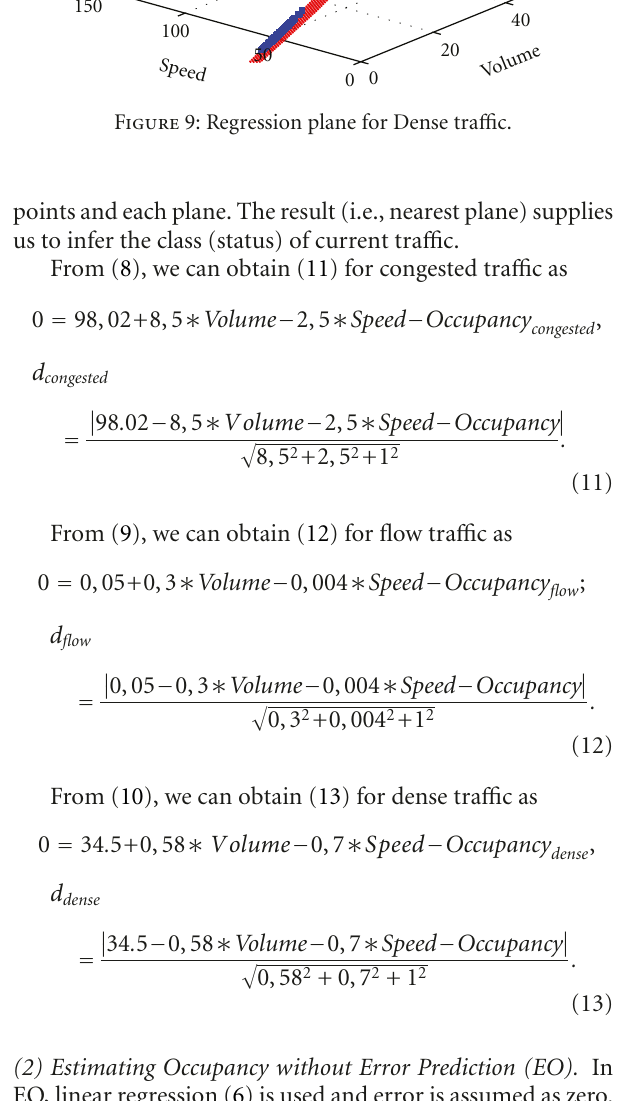
Figure 10: Composite regression planes of all tra ffi